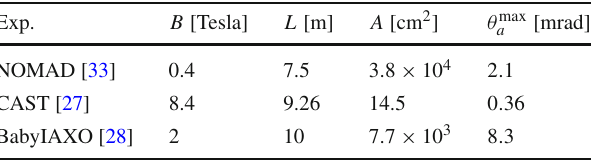
Table 1 Experimental parameters for the magnetic field area of the benchmark experiments Exp.